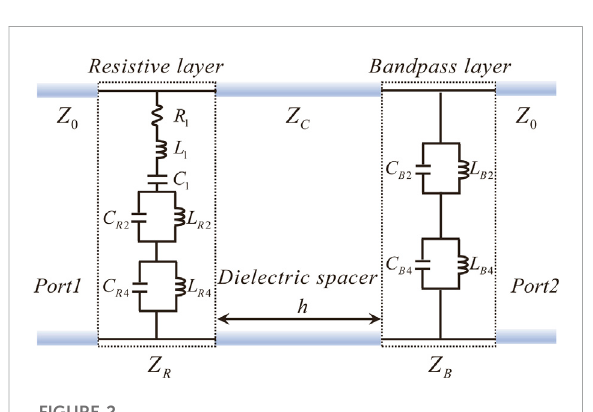
FIGURE 2 Equivalent circuit model of the cascaded